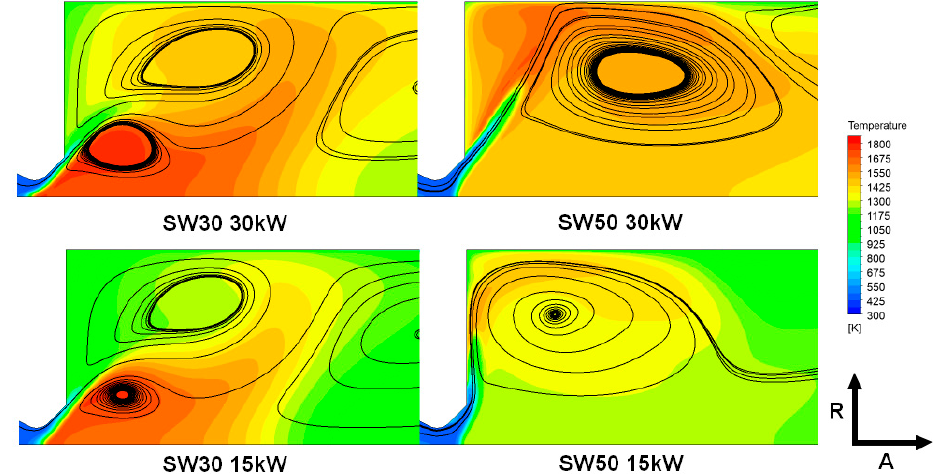
Figure 6. Temperature contours and streamlines location, φ = 0.71.